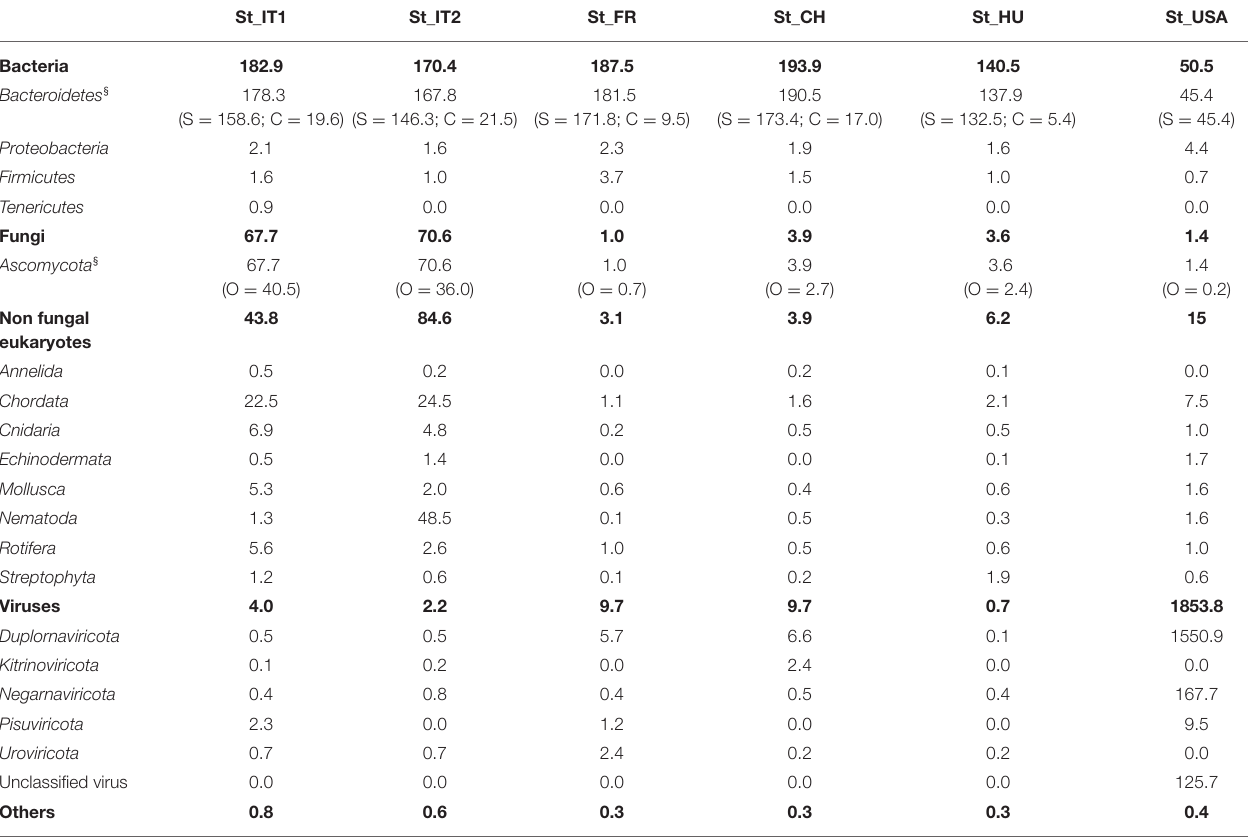
TABLE 2 | Reads assigned to phyla other than Arthropoda expressed as